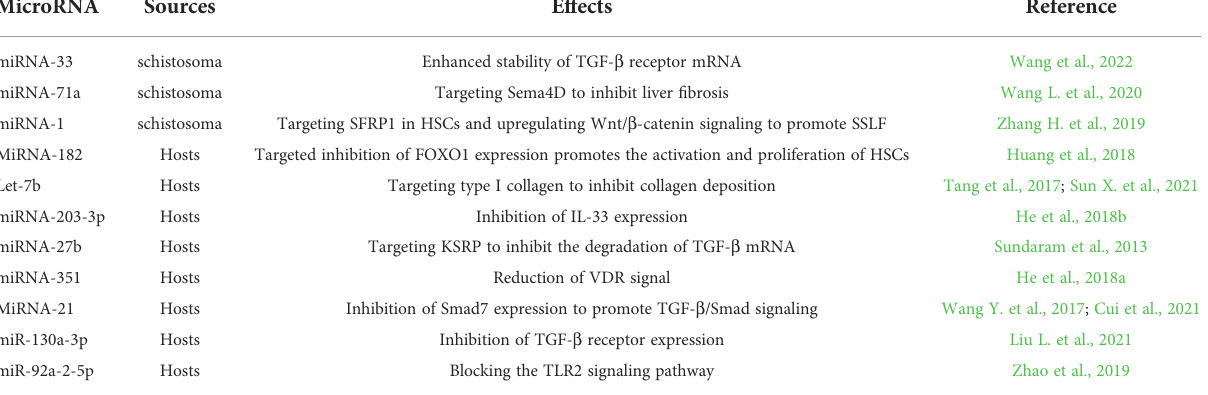
TABLE 1 The role of MicroRNA in schistosoma-associated liver fi